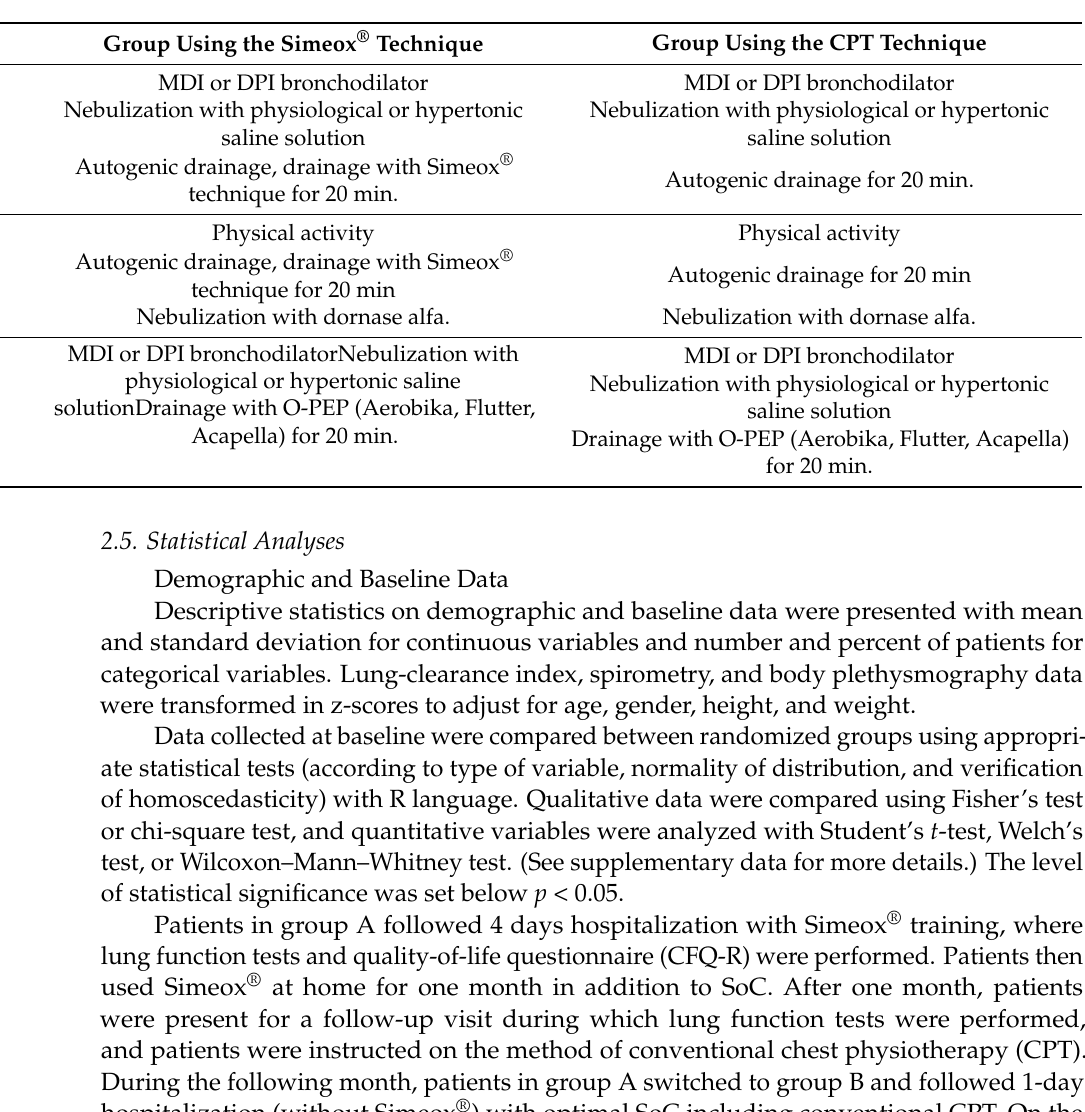
Table 1. Planned care program in each group with and without Simeox ®